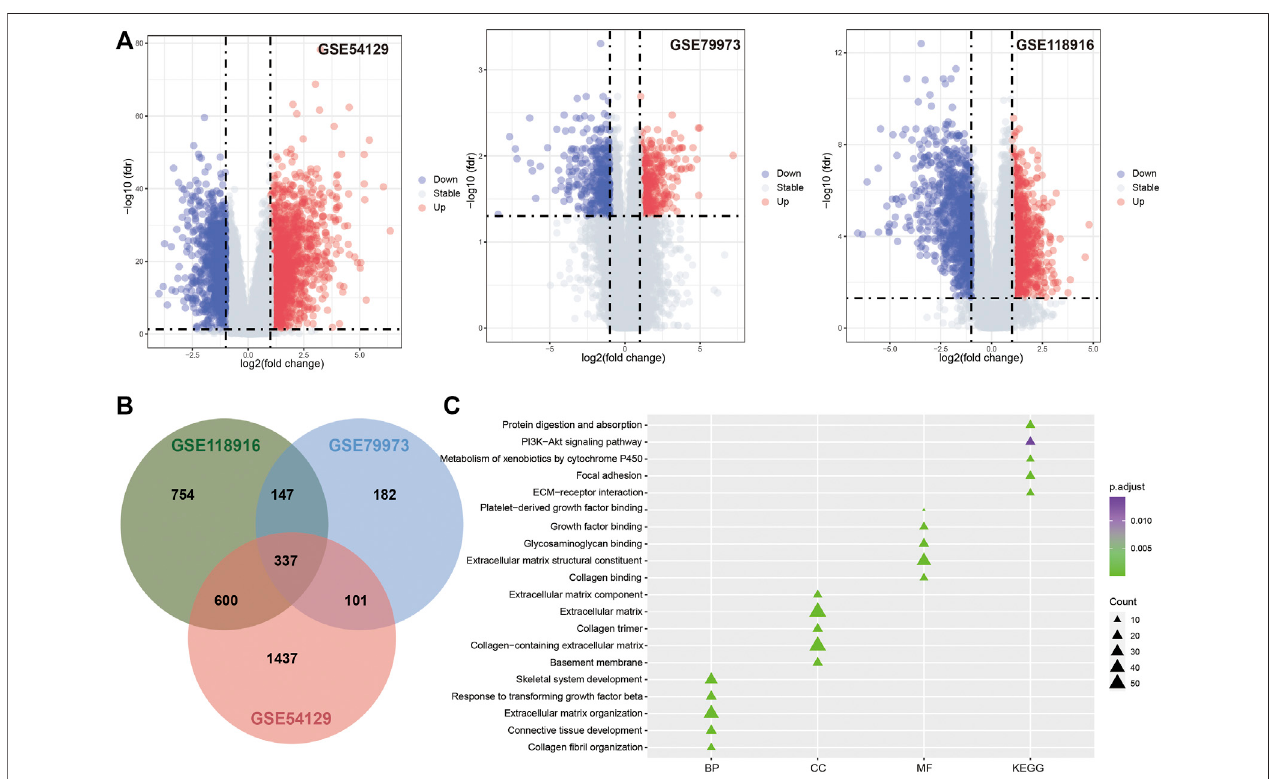
FIGURE 2 | Differentially expression analysis results. (A) . Volcano plot for GSE54129, GSE79973 and GSE118916. (B) . The Venn diagram for DEGs identi fi ed in three GEO datasets. (C) . The functional enrichment analysis results for